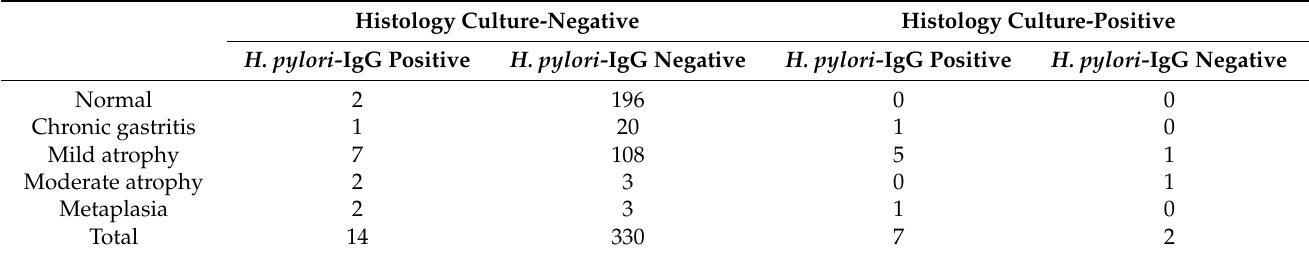
Figure 2. Distribution of histology assessment results among H. pylori- positive and -negative samples. A statistically significant difference in neutrophil, monocyte, and atrophy scores between the H. pylori- positive and -negative subjects was observed in the antrum, angulus, and body ( p < 0.001) according to at least one positive result from several diagnostic methods. Only one subject was reported to have a metaplasia. Table 2. Gastric mucosal status of